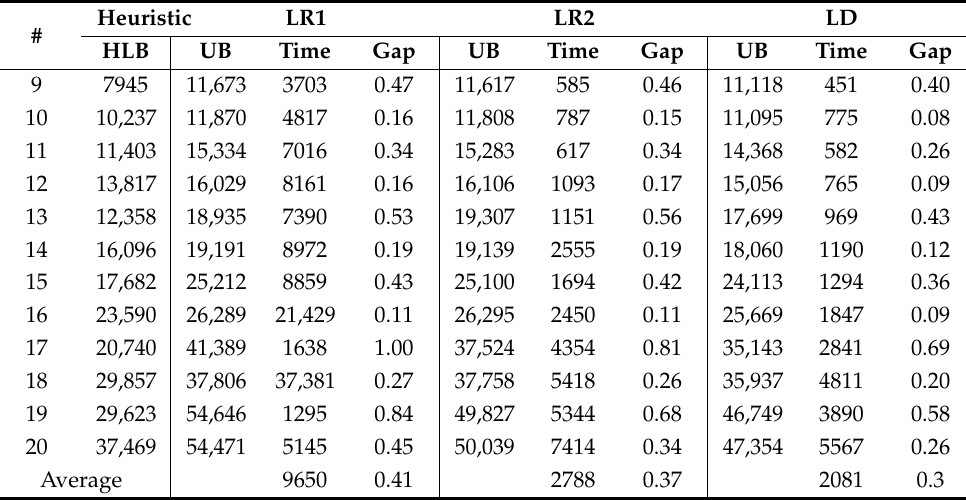
Table 11. Computational results for fixed lower bound method for LR1, LR2, and